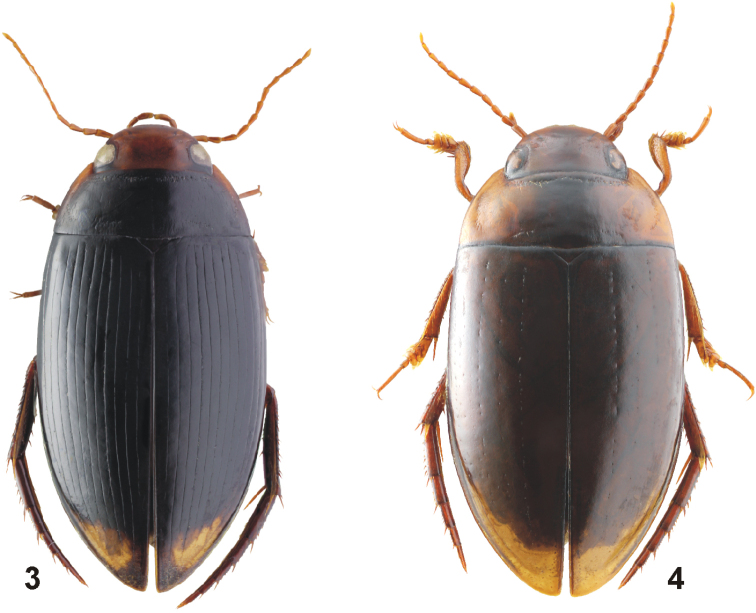
Habitus of Copelatus3C.
kietensis sp. nov. (holotype; TL: 6.3 mm) 4C.
laevipennis sp. nov. (holotype; TL: 6.9 mm).